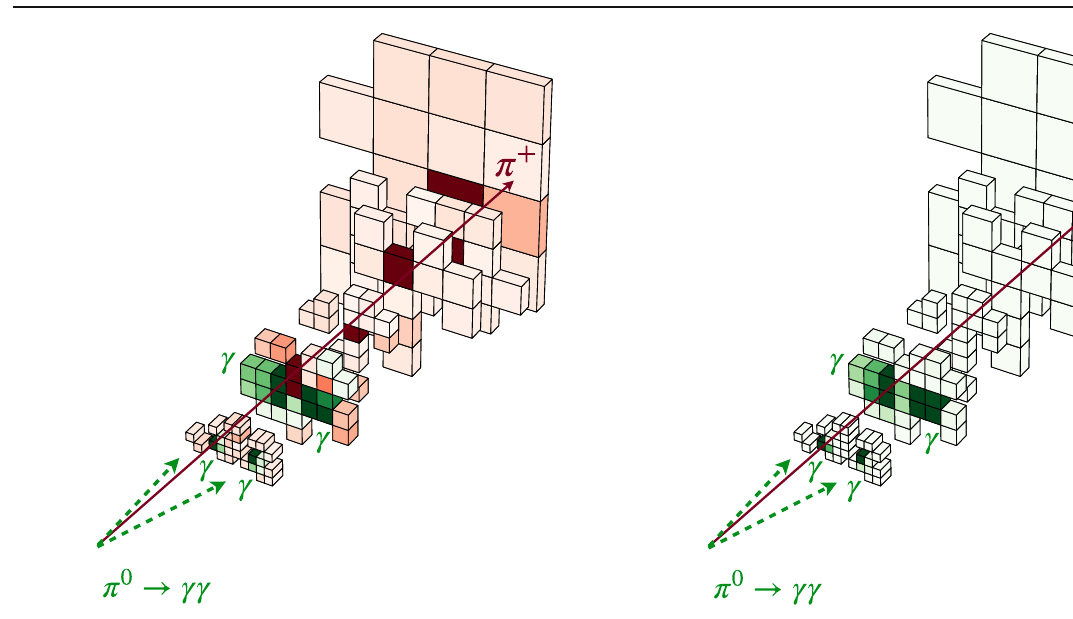
where the deposits from the two photons are resolved (right). The π + track and its extrapolation to the calorimeters are also